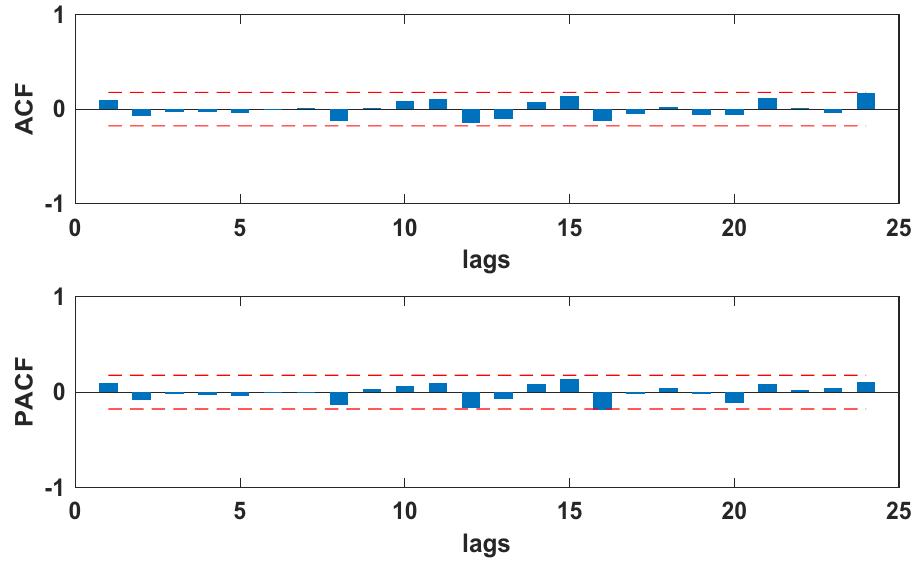
Figure 5. The ACF and PACF of residual sequence of the SARIMA((1,4,5,7),0,0)(0,1,2) 12 model.